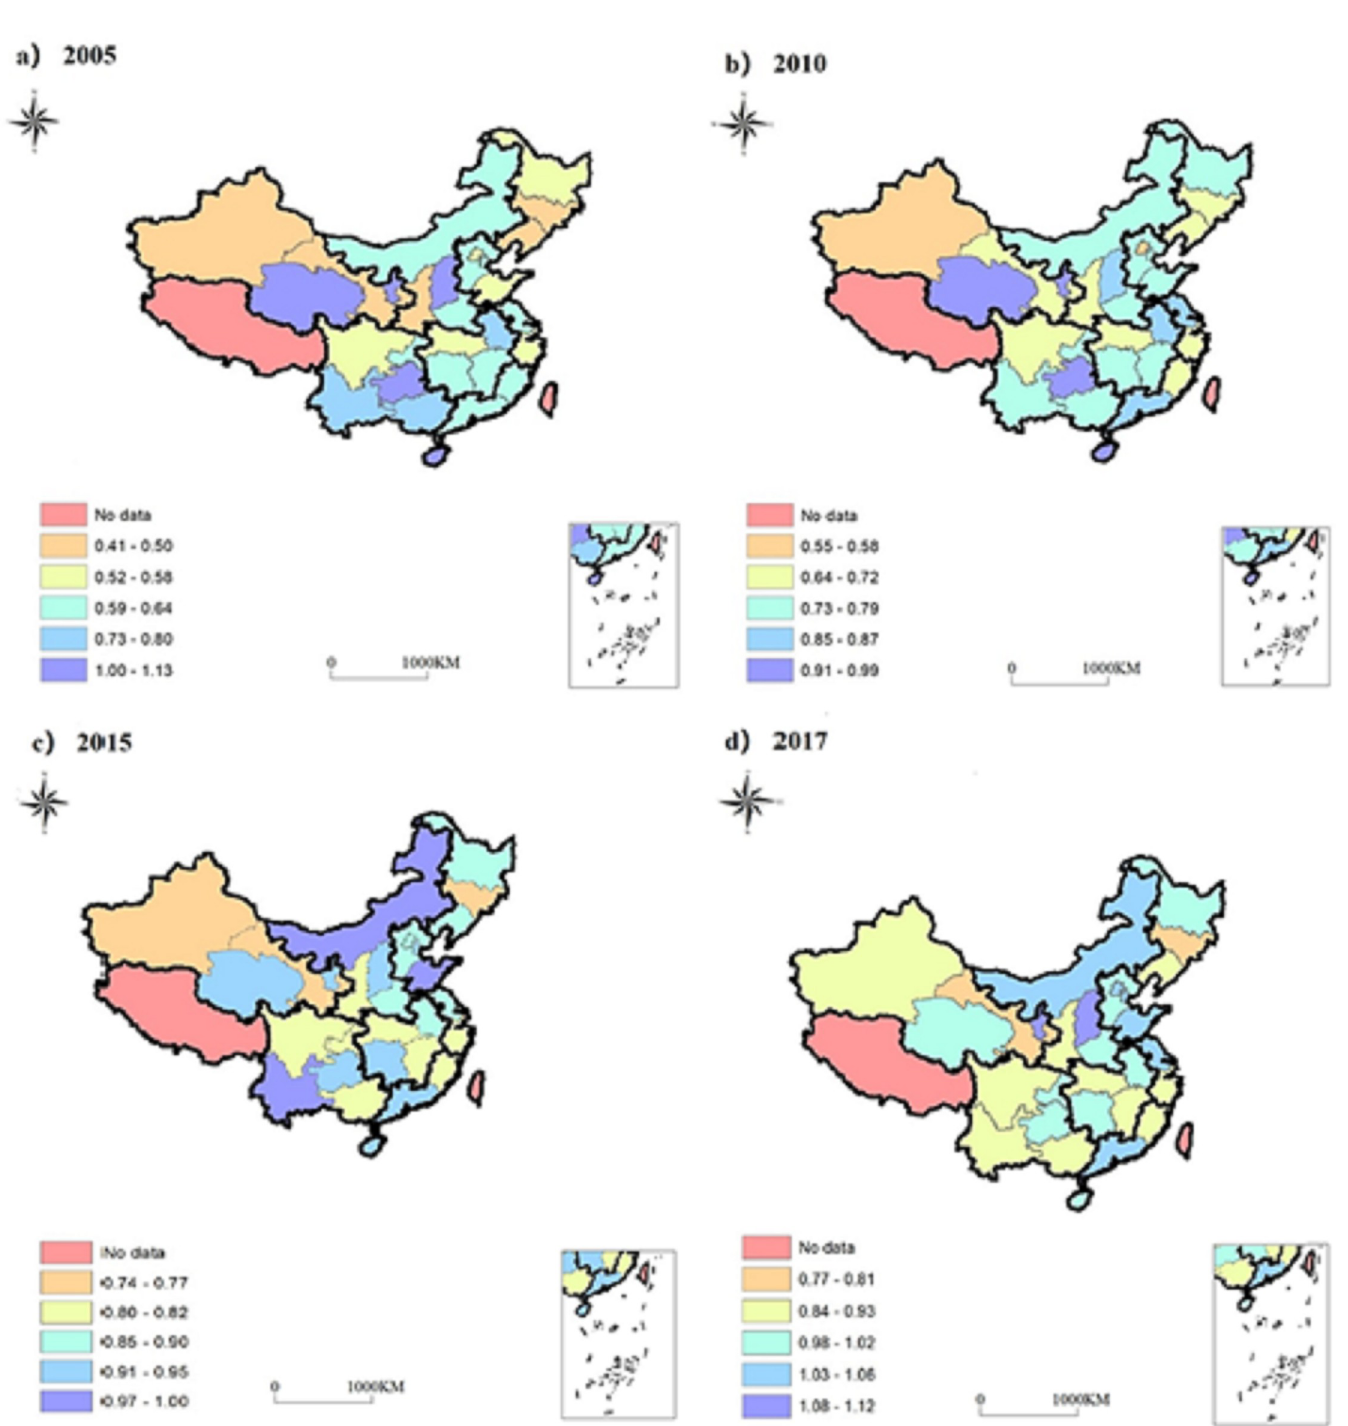
Fig 3. The spatial pattern of carbon emission performance of various provinces from 2005 to 2017.